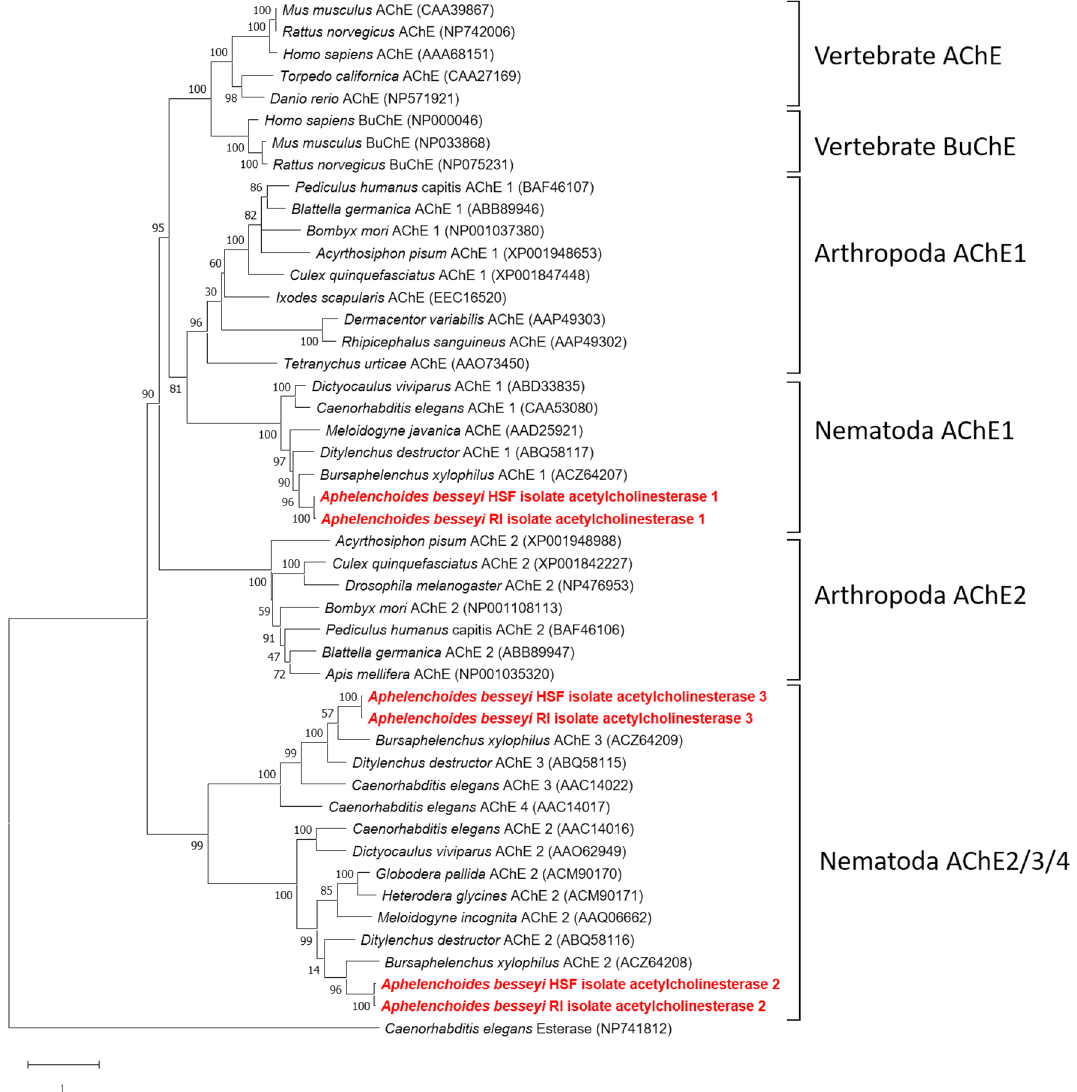
Figure 3. A maximum likelihood phylogeny of six AbeAChEs; Abace1-Rl (MT431320), Abace2-Rl (MT431322), Abace3-Rl (MT431324), Abace1-HSF (MT431321), Abace2-HSF (MT431323), and Abace3-HSF (MT431325) with the AChEs and BuChEs from Vertebrata, Arthropoda and Nematoda. The phylogenetic tree was generated using a ClustalW alignment and maximum likelihood tree with 500 bootstrap replicates using MEGA 7.0.21 47 (https:// mega. softw are. infor mer. com/7. 0/). GenBank accession numbers of each gene are indicated in parentheses. AbeAChEs are marked in bold and